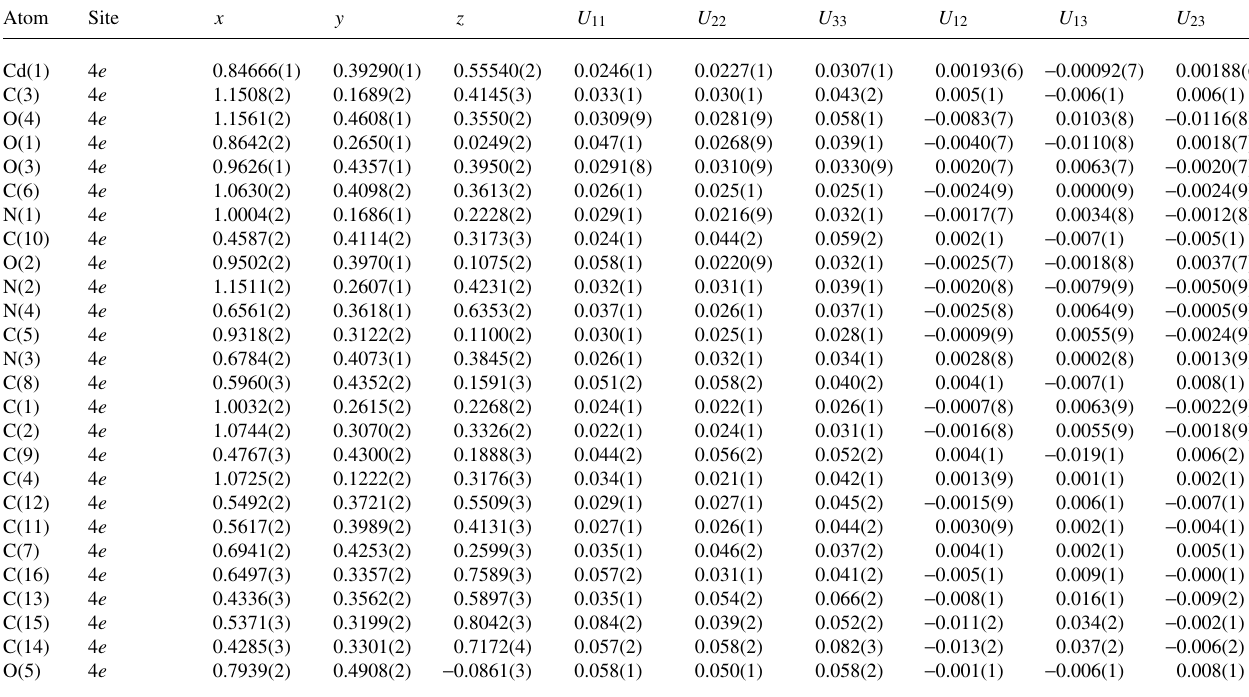
Table 3. Atomic coordinates and displacement parameters (in Å 2 ) .